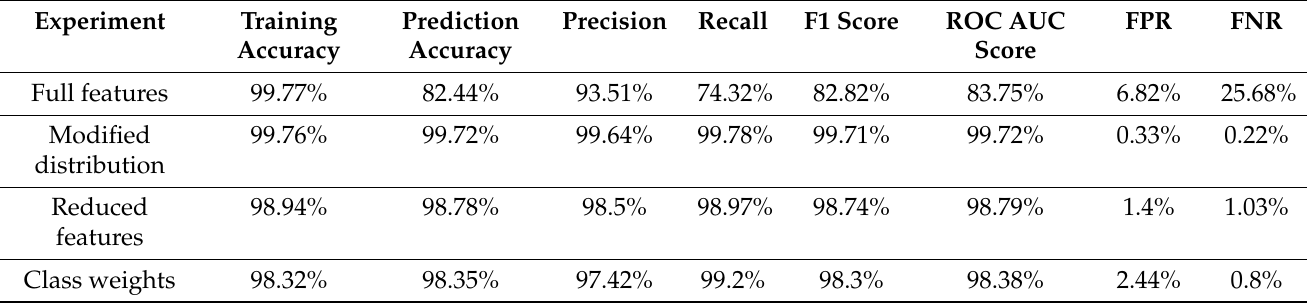
Table 20. Comparison of the results achieved in the NSL-KDD binary classification experiments.